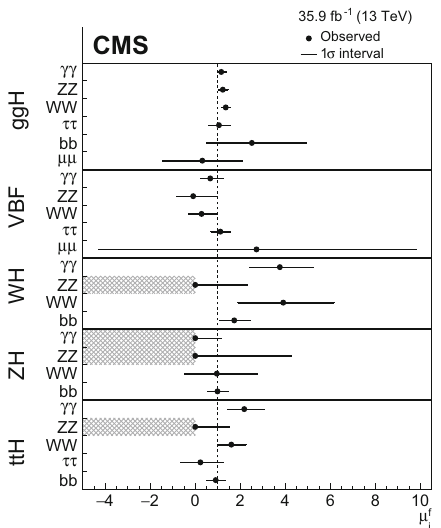
Fig. 6 Summary plot of the fit to the production–decay signal strength = μ μ f . The points indicate the best fit values while the products μ f i i horizontal bars indicate the 1 σ CL intervals. The hatched areas indicate signal strengths that are restricted to nonnegative values as described in the text